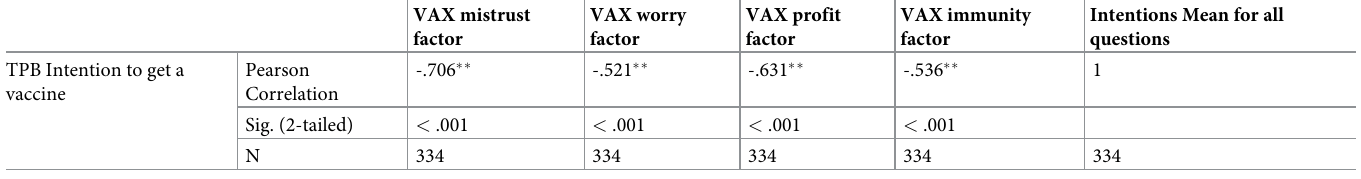
Table 4. Pearson product moment correlations between VAX subscales and intention to get a